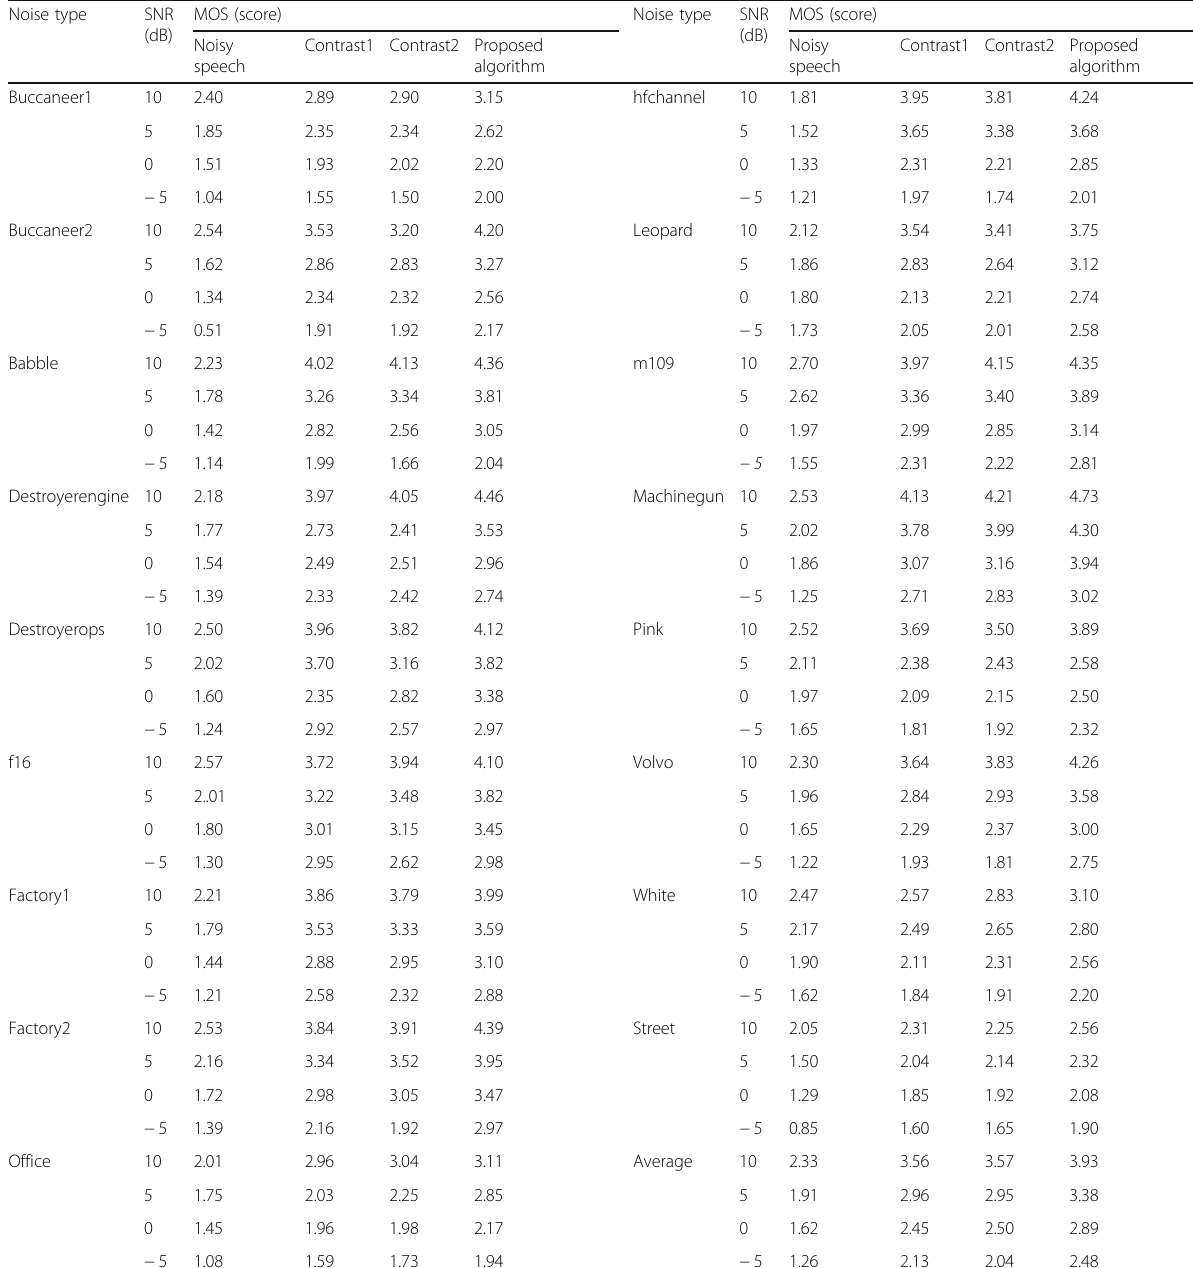
Table 8 The MOS of the proposed algorithm and the contrast algorithm Noise type